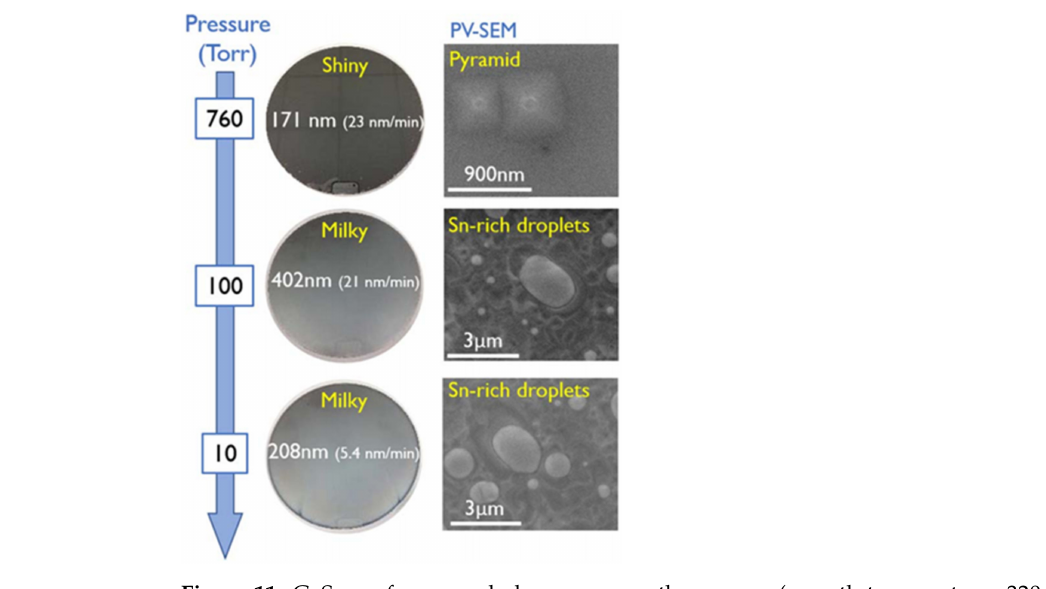
Figure 11. GeSn surface morphology vs. growth pressure (growth temperature: 320 ◦ C; growth pressure: 10, 100, and 760 Torr; precursors: Ge 2 H 6 and SnCl 4 ). Reproduced with permission from [119], IOP Publishing, 2018.